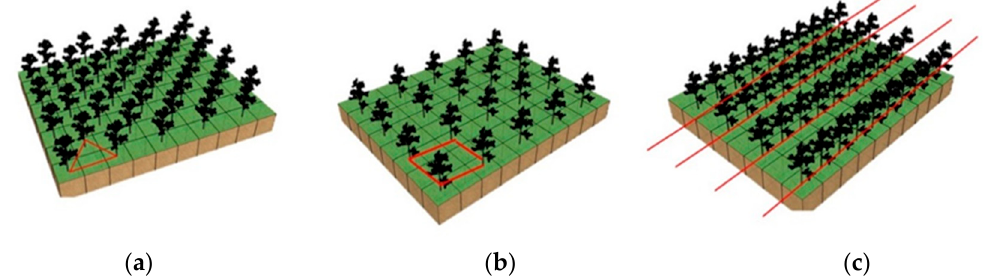
Figure 5. Several periodic lattices of NMs: ( a ) triangle lattice; ( b ) rectangular lattice; ( c ) square lat-